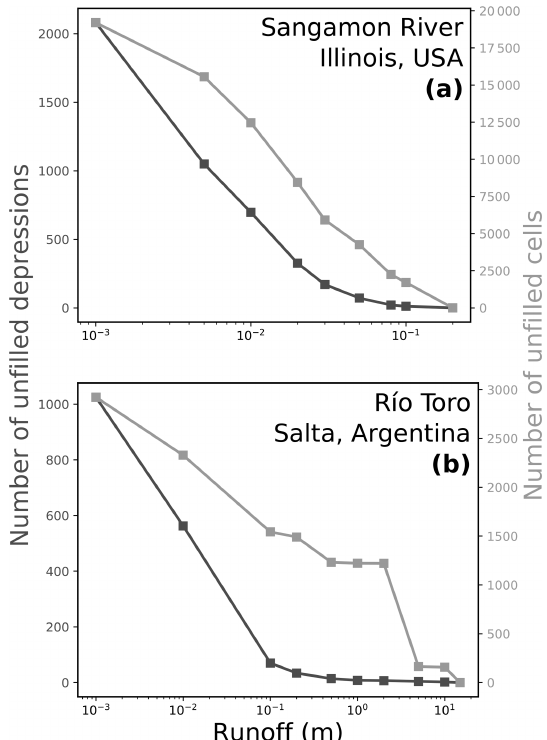
Figure 9. Number of cells (light grey) and depressions (dark grey) that remain unfilled under different starting runoff depths in (a) the Sangamon River basin and (b) the Río Toro basin sites. Similar trends are seen at both study sites, with higher runoff resulting in more depressions being completely filled. See the Supplement for exact